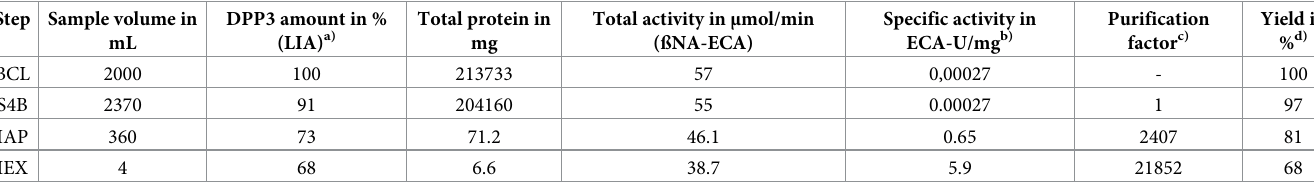
Table 2. Purification of DPP3 from human BCL.